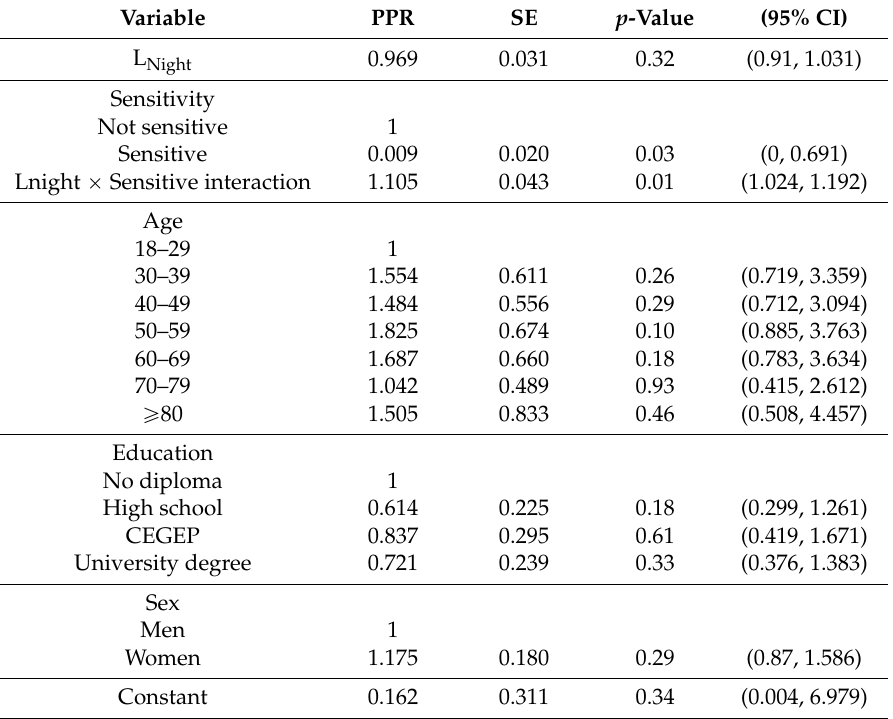
Table A12. L Night and marginal proportions of sleep disturbance by transportation noise in the weighted study sample, adjusted for sensitivity to noise: regression